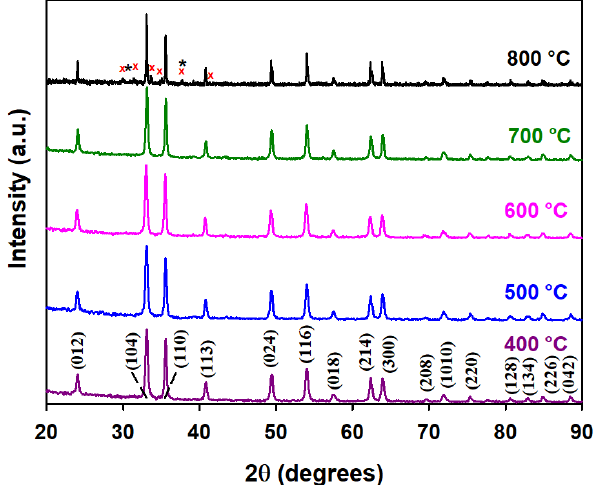
Figure 2. XRD patterns of the 100 Fe:5 K material calcined at the temperature indicated in each panel. The assigned Miller indices match the hematite phase of iron oxide. The peaks are marked as black asterisks (*) for K 2 O and as red crosses ( × ) for K 2 Fe 22 O 34